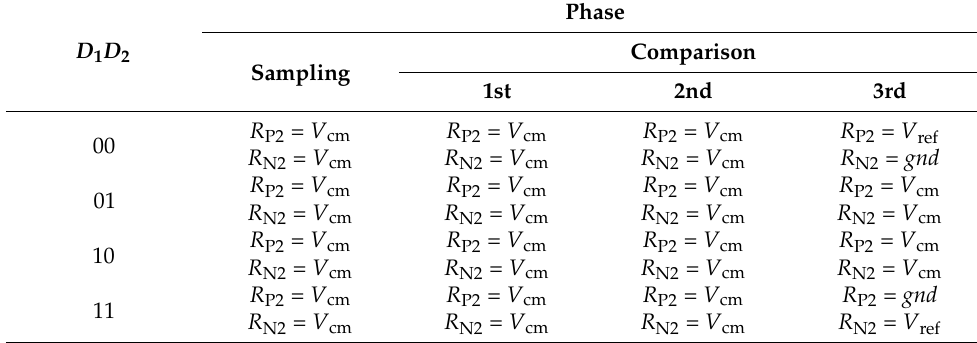
Table 3. R P2 and R N2 for each phase of 9-bit and 10-bit mode.